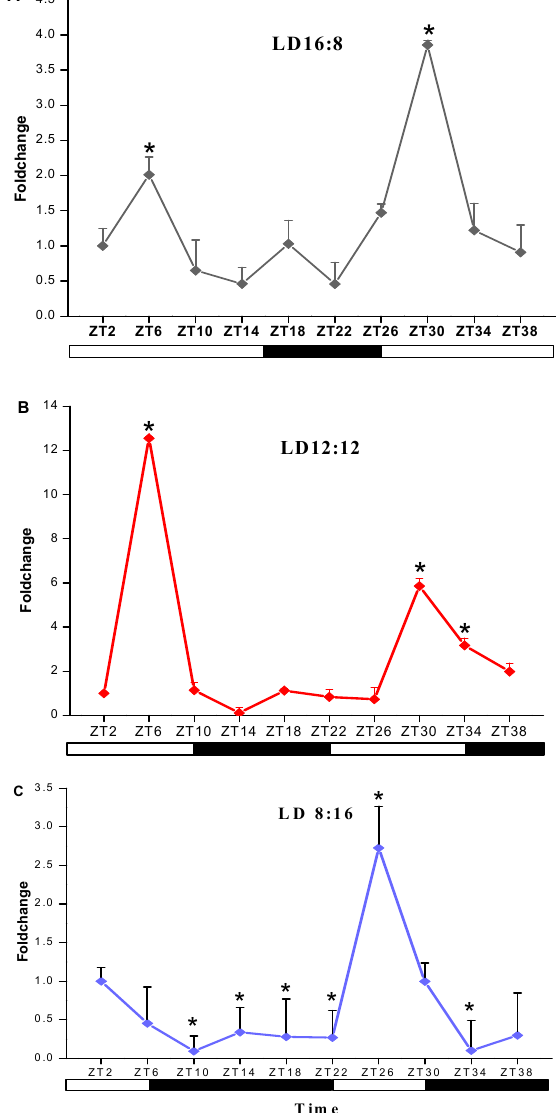
Figure 4. Transcription analysis of sjCRY-DASH under light / dark (LD) treatments of ( A ) LD16:8, ( B ) LD12:12 and ( C ) LD8:16. The expression levels at di ff erent times are presented as the fold change relative to that at Zeitgeber Time 2 (ZT2). Each test was performed in six biological samples. The data in the figures represent the averages ± standard deviation.* p < 0.05 based on one-way